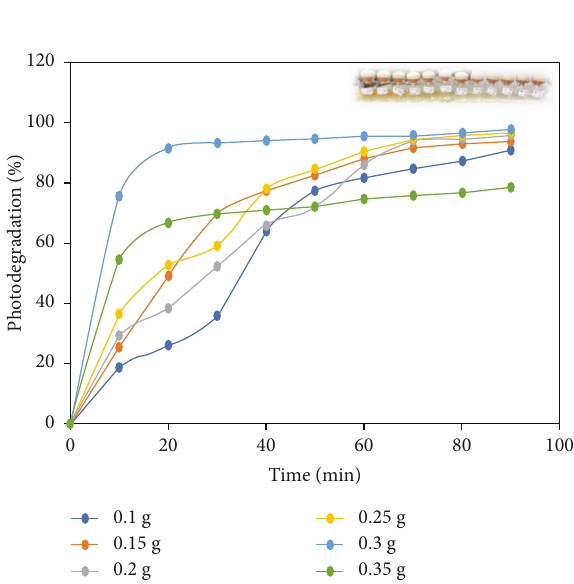
Figure 4: Variation of % of photodegradation versus time interval for the photodegradation of MO with a di ff erent dosage.